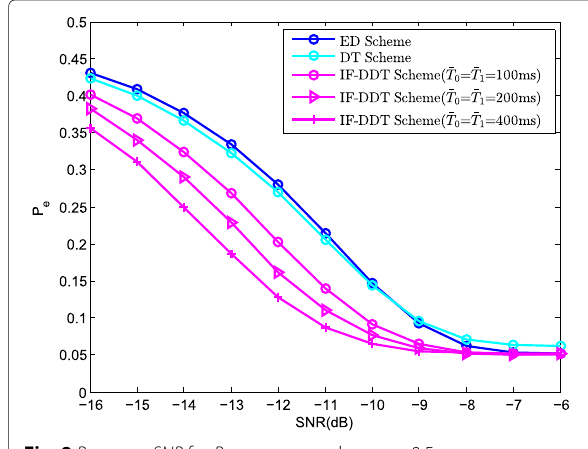
Fig. 8 P e versus SNR for P f ,target = 0.1 and η PU = 0.5